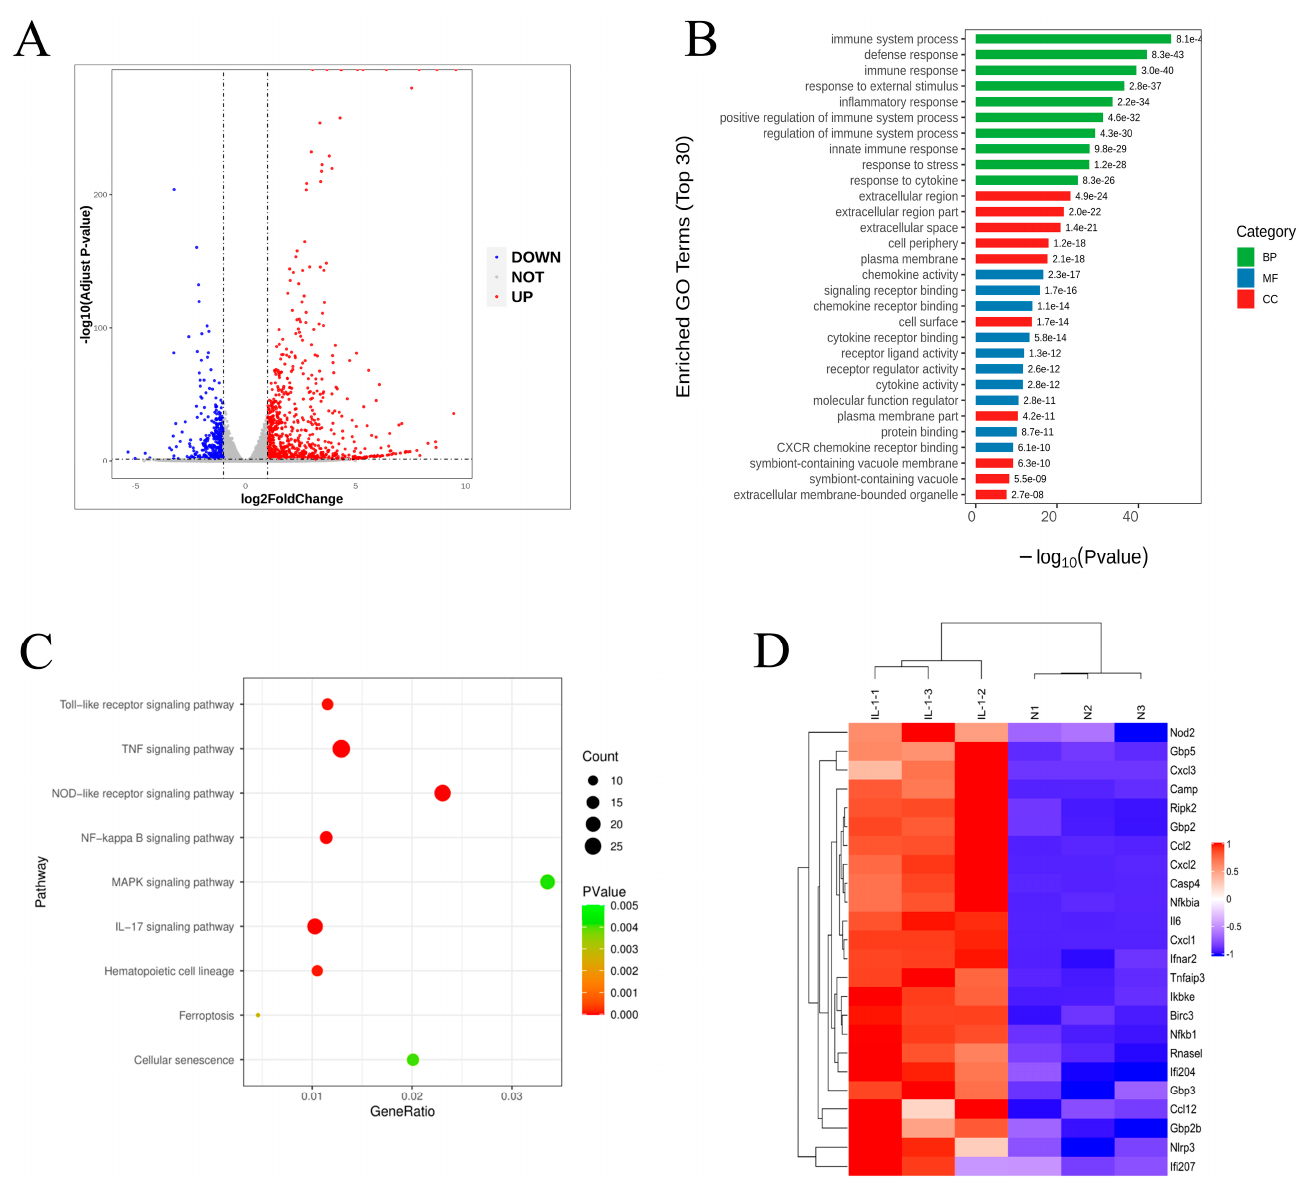
Figure 2. Transcriptome analysis of inflammation induced by IL-1 β on the functionality of chondro- cytes. ( A ) Volcano plot showing comparative gene expression in normal chondrocytes and chon- drocytes induced by IL-1 β ( n = 3). Red dots indicated the significantly increased transcripts (870), and blue dots represented the significantly decreased transcripts (368) in inflammatory chondro- cytes induced by IL-1 β (|log 2 FC| > 1, padj < 0.05). ( B ) GO enrichment analysis for differential gene expression in normal chondrocytes and inflammatory chondrocytes. GO enrichment analyses were performed for each of the three GO categories: BP, MF, and CC. ( C ) KEGG pathway analysis of differential gene expression in normal chondrocytes and inflammatory chondrocytes. ( D ) A heat map showing hierarchical clustering of differential gene expression along the NOD2 signaling path- way in normal and inflammatory chondrocytes. Red indicated high relative expression, and blue represented low relative expression.